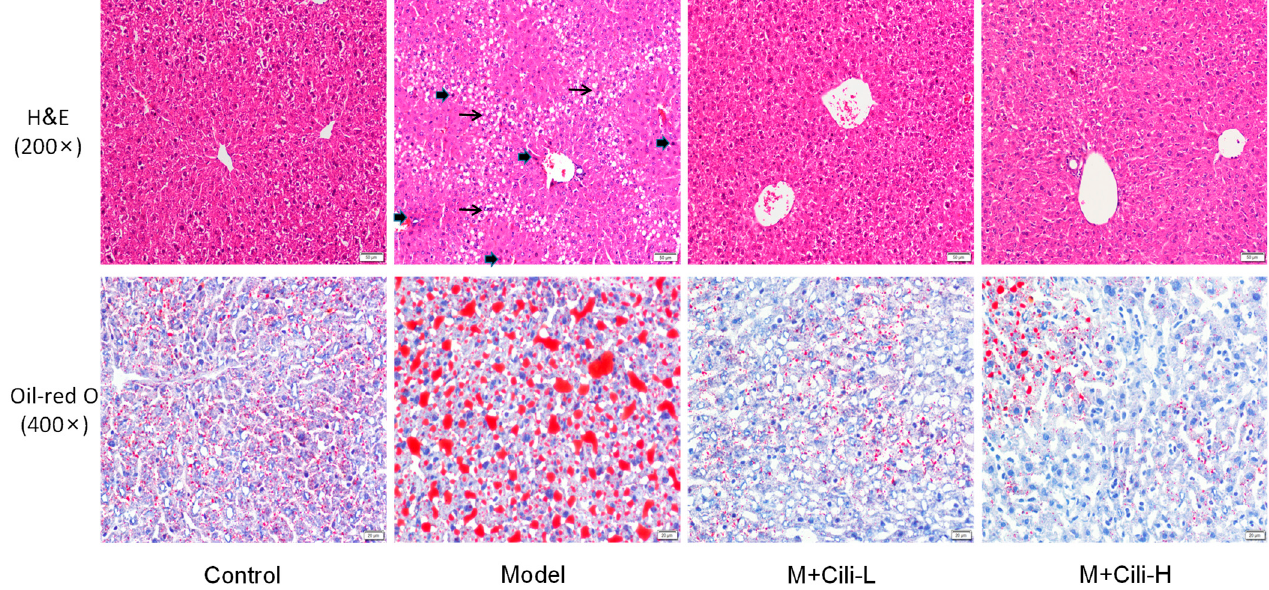
Figure 4. Representative photos of haematoxylin and eosin (H&E) staining ( top ) and Oil-red O staining ( bottom ). Model mice were fed Lieber-DeCarli liquid diet containing 5% alcohol with or without Cili (4 mL and 8 mL/kg for 28 days). Control mice received liquid diet without alcohol. Magnification for H&E (200×), for Oil-red O (400×). Thin arrows indicate hepatocyte vacuolation, slight swelling and degeneration, and thick arrows indicate foci of apoptosis/necrosis.